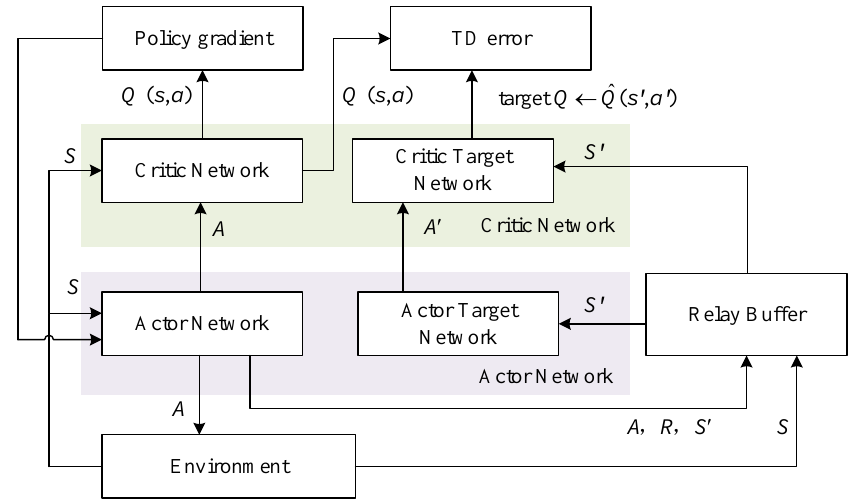
Figure 2. Actor–critic architecture of path-following and obstacle avoidance